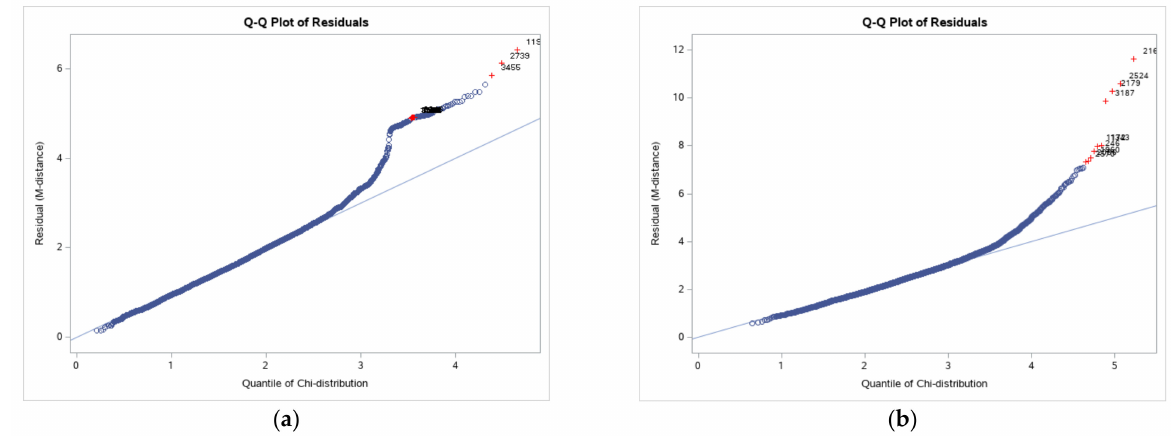
Figure 5. Q-Q plot of residuals ( a ) pre-trial data set and ( b ) post-trial data set.